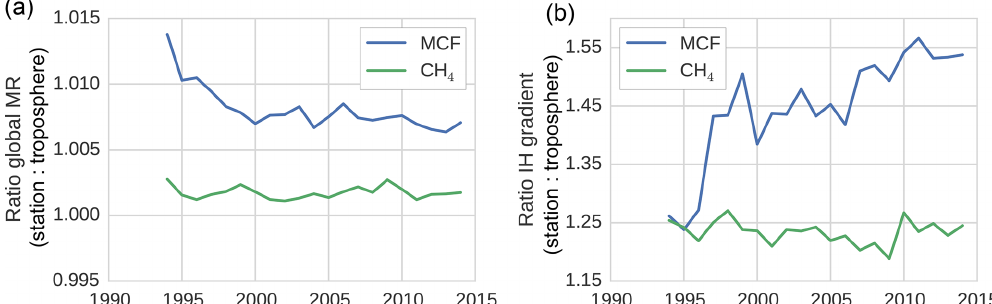
Figure 3. The surface sampling bias in the global mixing ratio (MR) (a) and in the IH gradient (b) of MCF and of CH 4 . The bias was quantified as the ratio between values derived from the NOAA surface sampling network and values derived from the full (TM5) troposphere. The biases were derived from 27 and 12 sites for CH 4 and for MCF, respectively. Figure 1 visualizes the impact of correcting for the sampling bias in real-world NOAA observations.